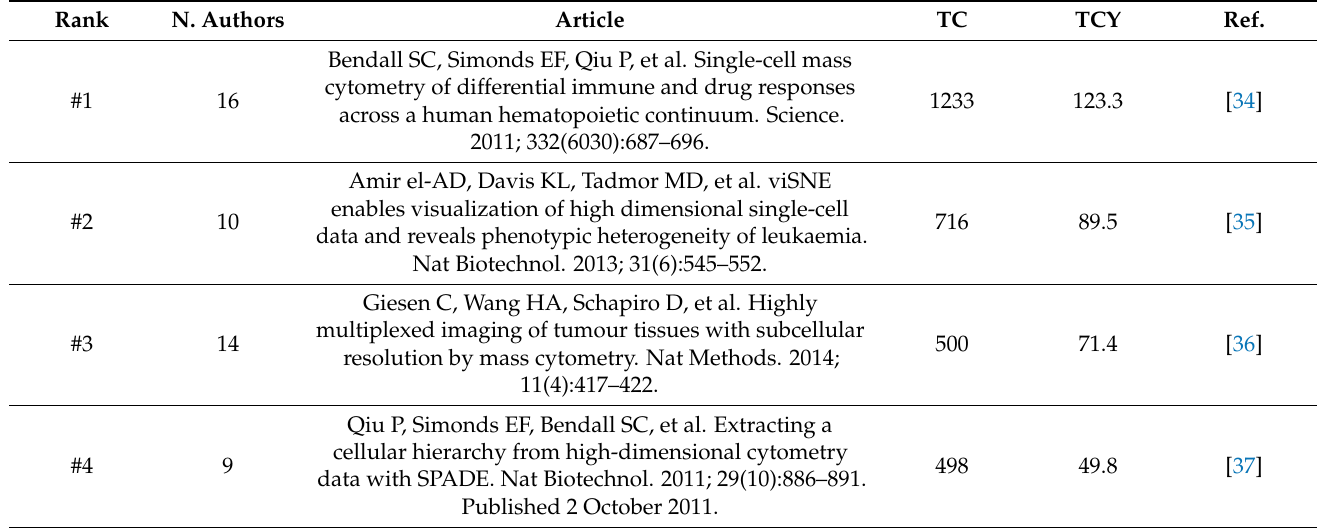
Table 6. Top 10 most highly cited papers in mass cytometry